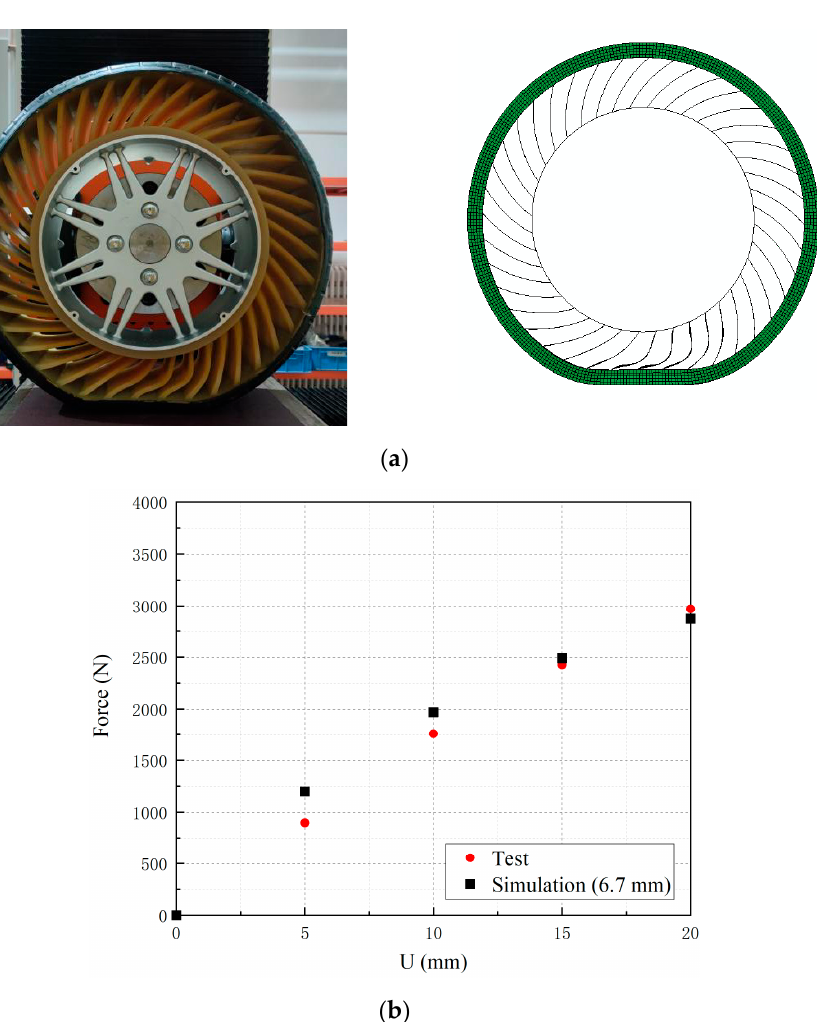
Figure 11. The experimental and simulation results of the NPT: ( a ) deformation of the test and simulation for the uniform-thickness NPT; ( b ) force-displacement of the test and simulation for the uniform-thickness NPT.